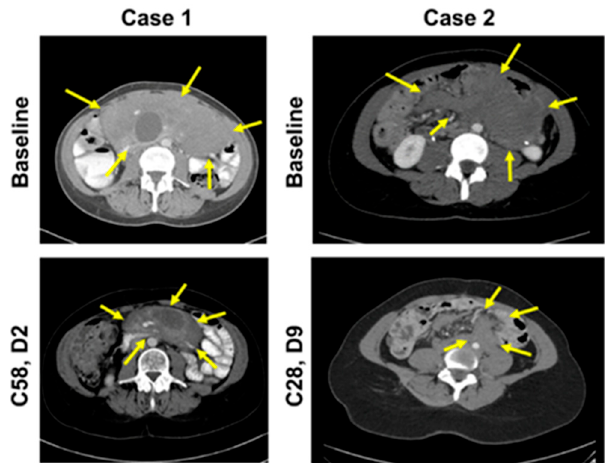
Figure 2. CT scans of target lesions at baseline and after achieving PR in both patients. Abbreviations: C, cycle; CT, computed tomography; D, day; PR, partial response.